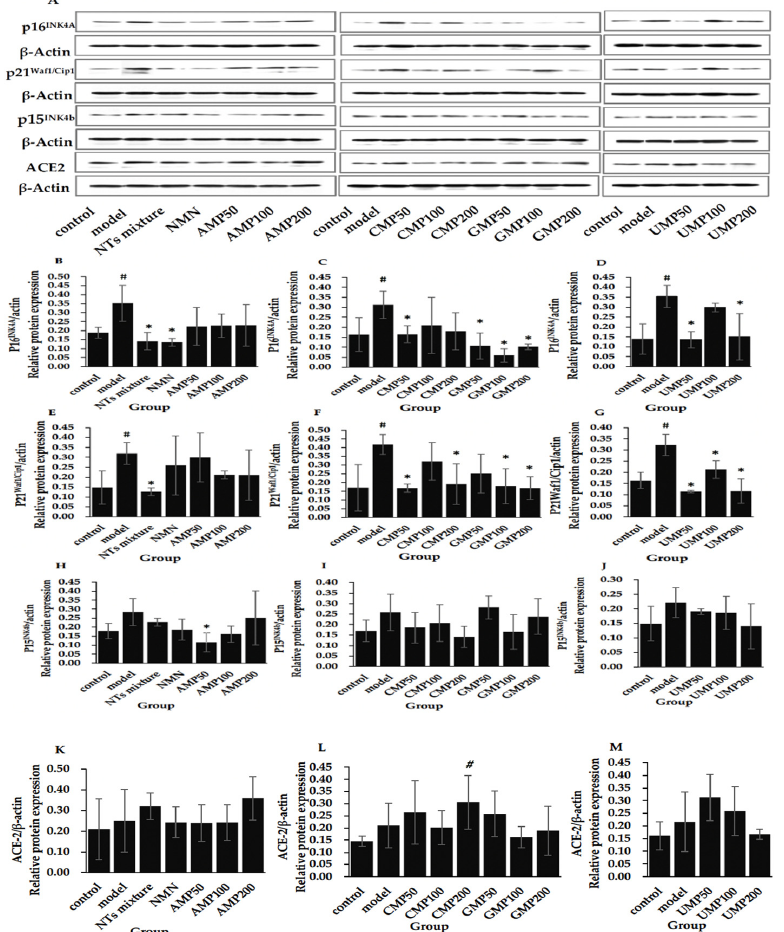
Figure 4. Effect of NTs on the protein expression of p16 INK4A , p21 Waf1/Cip1 , p15 INK4b , and ACE-2. ( A ) The Western blot strip in all groups; ( B , E , H , K ). The protein expression of p16 INK4A , p21 Waf1/Cip1 , p15 INK4b , and ACE-2 in the NMN and AMP50/100/200 groups; ( C , F , I , L ). The protein expression of p16 INK4A , p21 Waf1/Cip1 , p15 INK4b , and ACE-2 in the CMP50/100/200 and GMP50/100/200 groups; ( D , G , J , M ). The protein expression of p16 INK4A , p21 Waf1/Cip1 , p15 INK4b , and ACE-2 in the UMP50/100/200 group. Values represented the mean ± S.D. ( n = 3 per group). # p < 0.05 versus control group, * p < 0.05 versus model group.